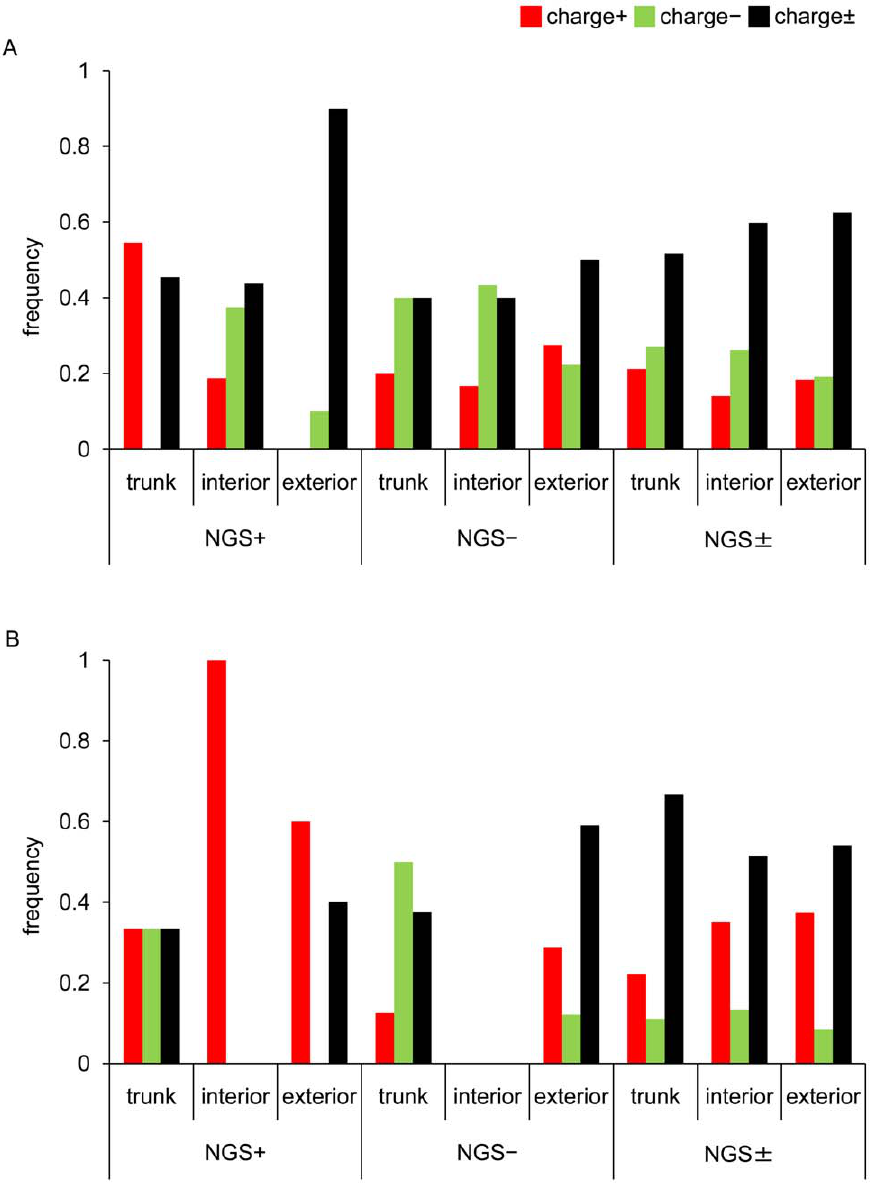
Figure 2. Patterns of amino acid substitutions in HA1 on different branches of phylogenetic trees. The proportions of charge + (red bar), charge 2 (green bar), and charge 6 (black bar) substitutions in HA1 on the trunk, interior, and exterior branches of the NGS + , NGS 2 , and NGS 6 branches are indicated for (A) A/H3N2 and (B) A/H1N1 viruses. The number of amino acid substitutions in HA1 is shown in Table S1.